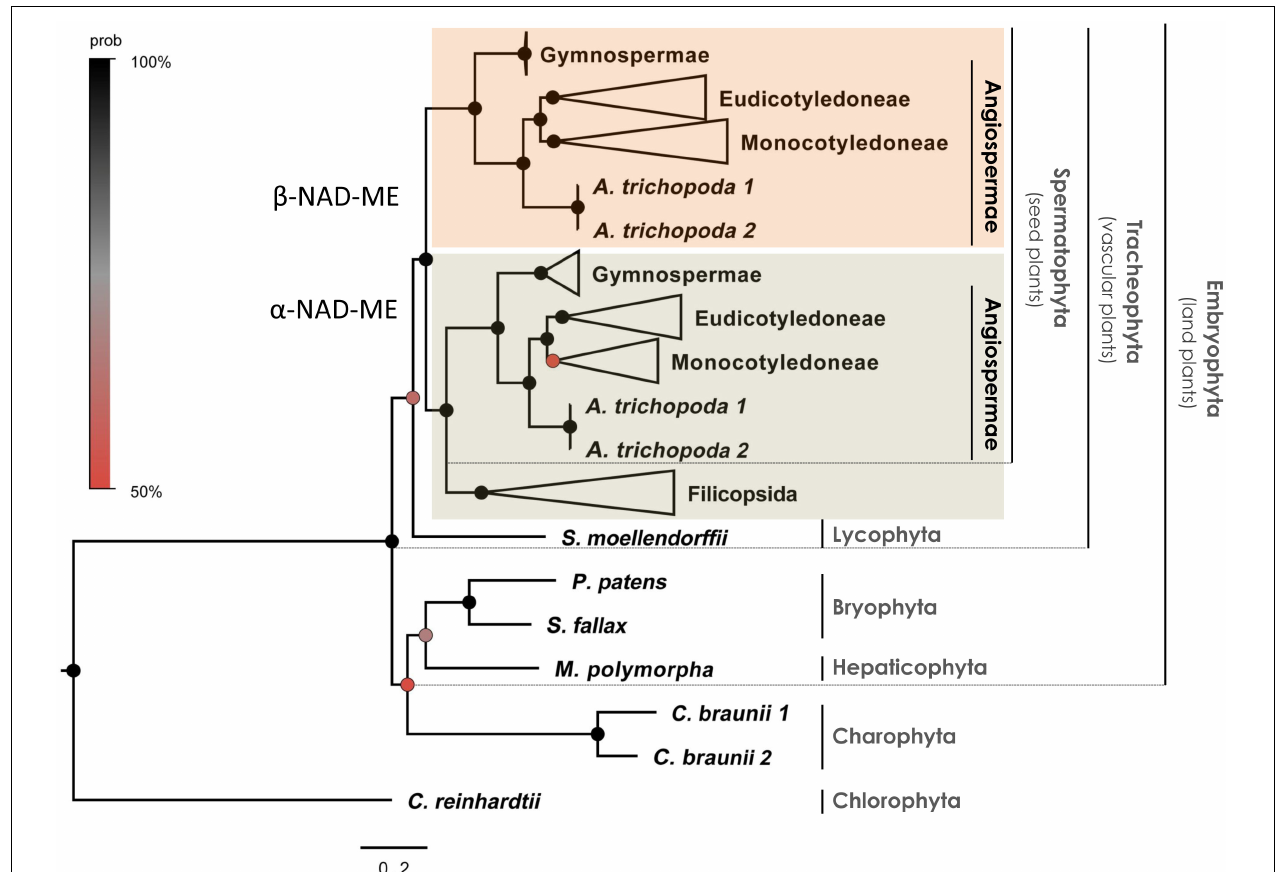
FIGURE 1 | Phylogenetic gene tree of α - and β -NAD-ME in the green lineage. The phylogenetic relationships were inferred from coding sequences using BI. The main clades are compressed and designated by their subdivision, class, order or family names. Black circles highlight nodes with Bayesian Posterior Probability (BPP) values higher than 90%, gray circles indicate BPP values higher than 70% and red circles indicate BPP values higher than 50%. The three positions of codons were optimized separately (partitioned tree). Best-fit substitution model was a GRT + G submodel (BPP = 0.90 ± 0.01) with individual rates values: m1 = 0.42, m2 = 0.33, and m3 = 2.74 for the 1st, 2nd, and 3rd position of codons, respectively. The full tree is available in Supplementary Data 1